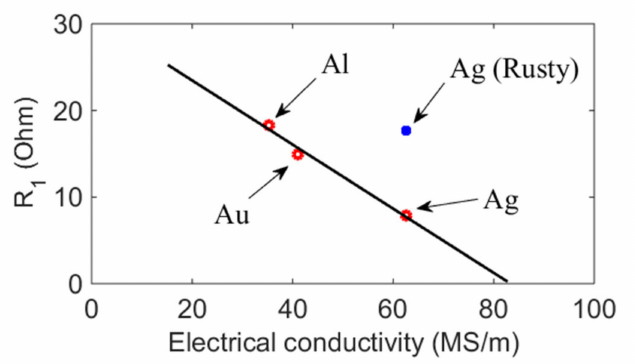
Figure 9. The linear relationship between electrode material conductivity and motional resistance R 1